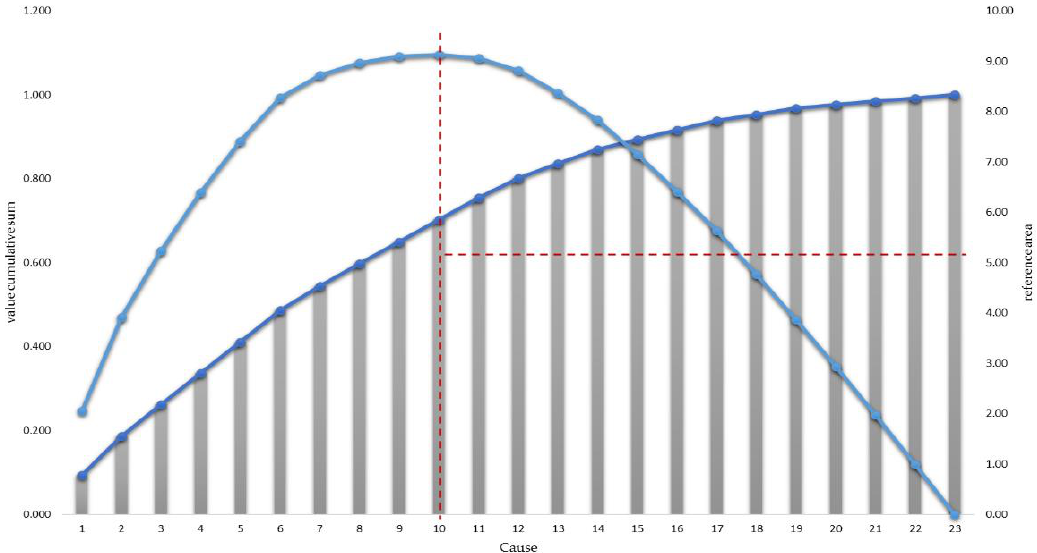
Figure 10. Graph of the Lorenz curve and the curve of the reference area.